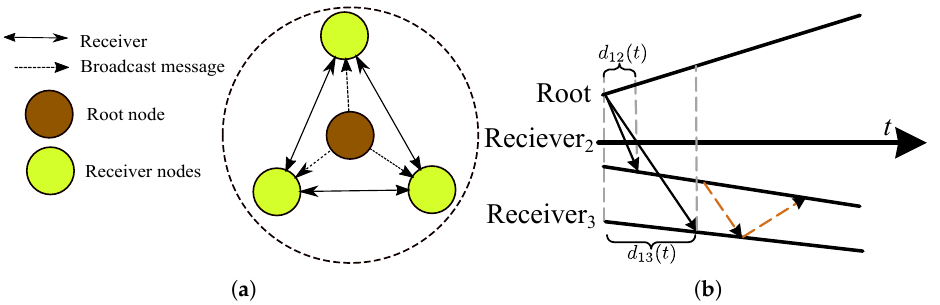
Figure 18. Receiver-receiver messaging scheme, where a root node emits a synchronization message, and all of its neighbors receive. Then, the receiver nodes exchange their local time along with the received reference time. In ( a ), a typical operation of the scheme, and in ( b ), timeline of message